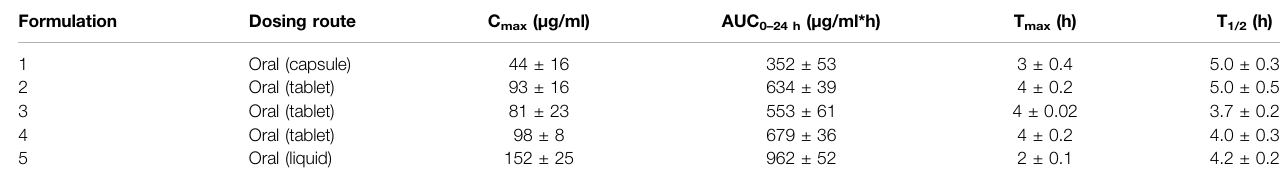
TABLE 3 | Pharmacokinetic parameters after oral administration of zapnometinib in beagle dogs. Formulation Dosing